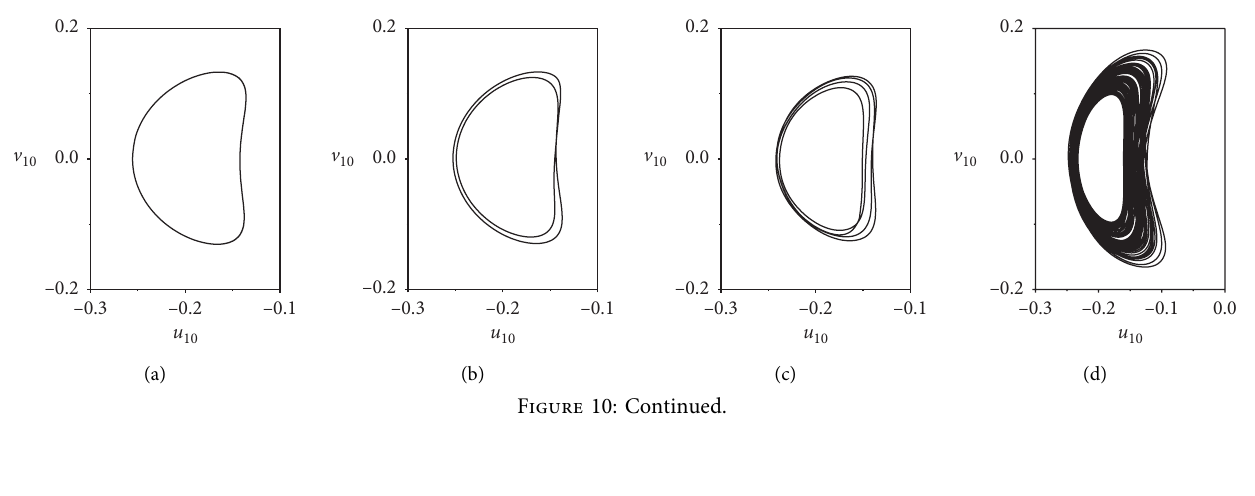
� 0.056 and g � 2 4